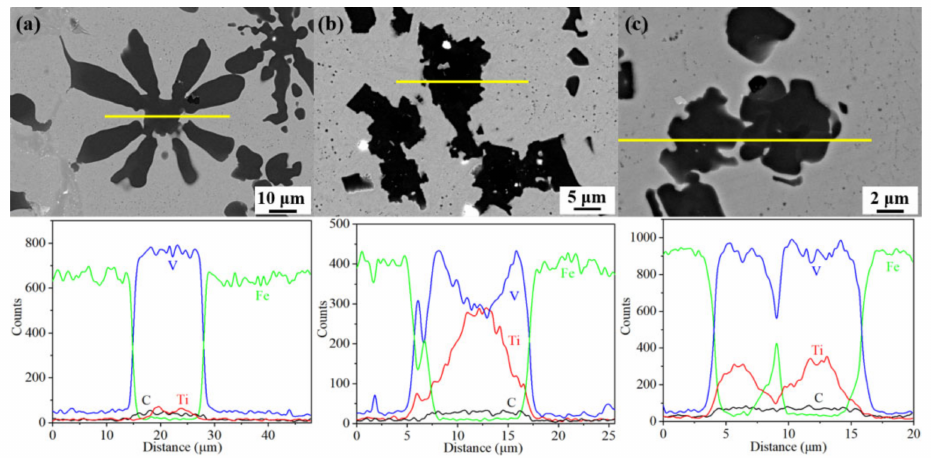
Figure 10. SEM image and the corresponding EDS composition in line scanning: ( a ) 1.5 Mn sample; ( b ) 3.0 Mn sample; and ( c ) 4.5 Mn